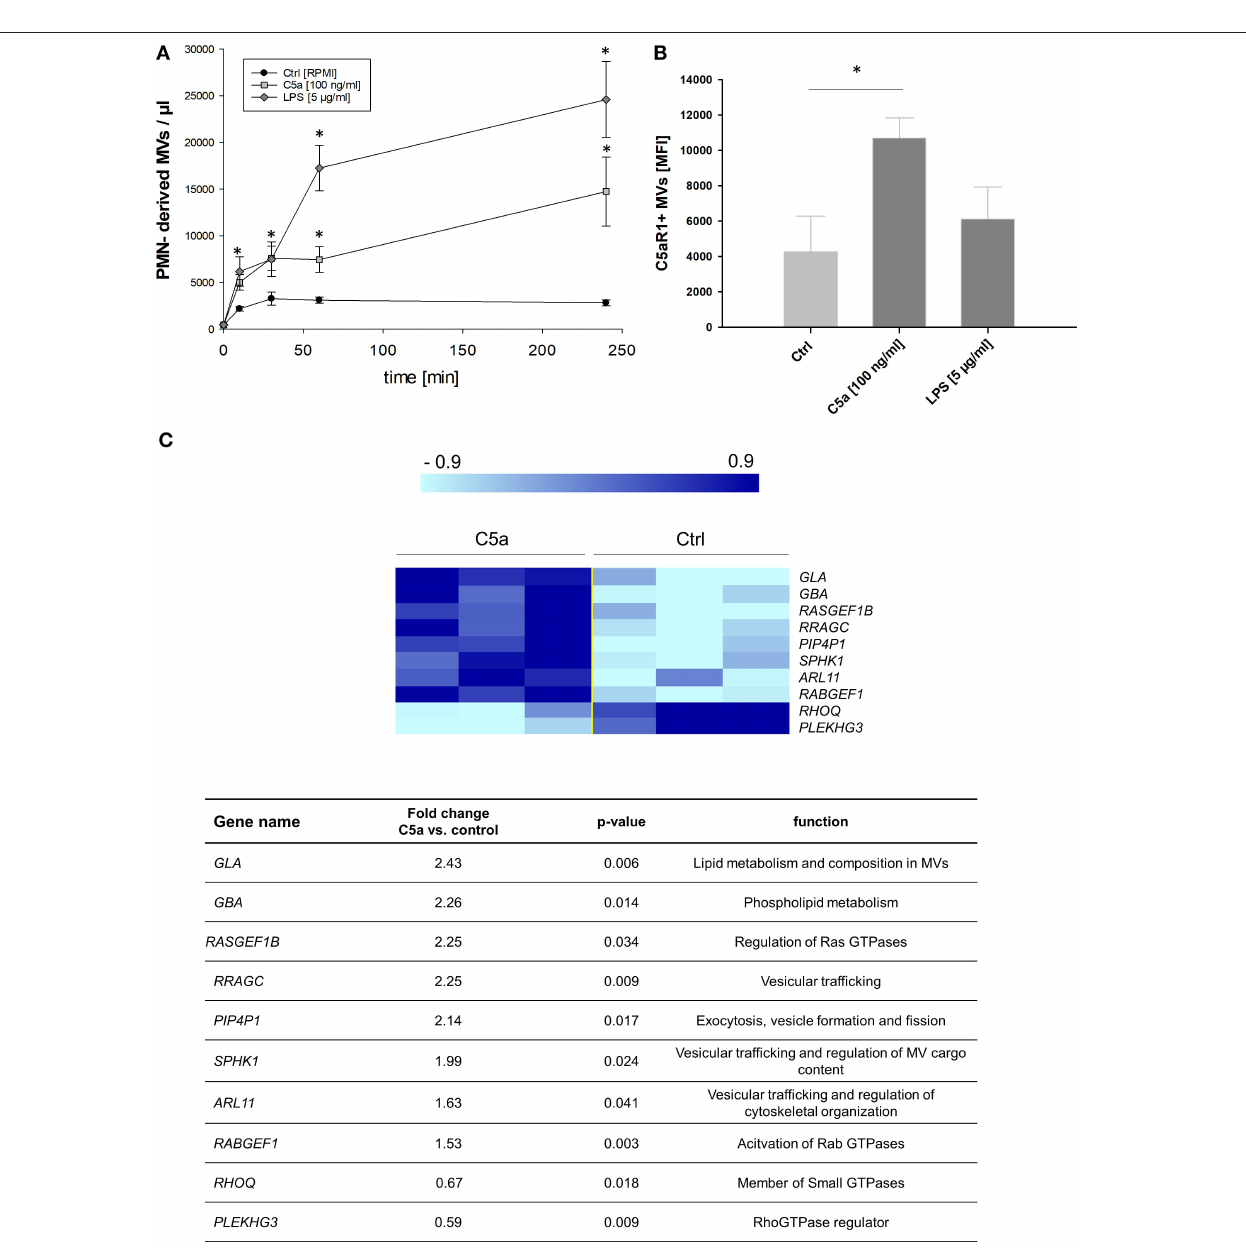
FIGURE 3 | C5a alters MV shedding in PMNs. (A) PMNs were stimulated for 0, 10, 30, 60, and 240min with C5a (100ng/ml) or LPS (5 µ g/ml) and supernatants were analyzed by FACS. Untreated cells served as control. n = 10, One-Way ANOVA followed by Student-Neuman-Keuls post-hoc testing was performed for each time point, * p < 0.05. (B) MVs from supernatants were further analyzed for expression of C5aR1 by FACS. n = 3 per group, * p < 0.05. (C) Heat map and gene list of selected and differentially regulated genes upon C5a treatment in in neutrophils after 1h ( n = 3 per